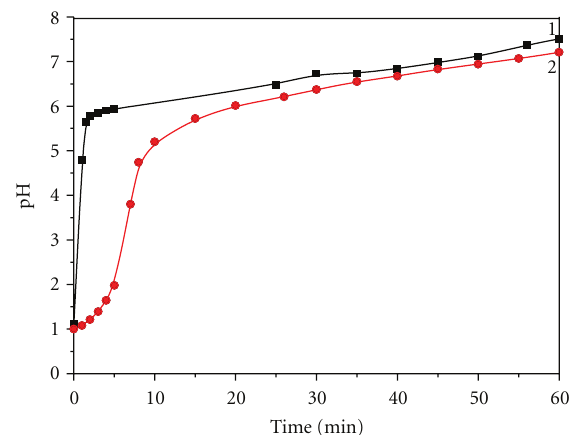
Figure 17: Kinetics of “Black antacid” (1) and “Rennie” (Switzer- land) (2) interaction with 0.1M